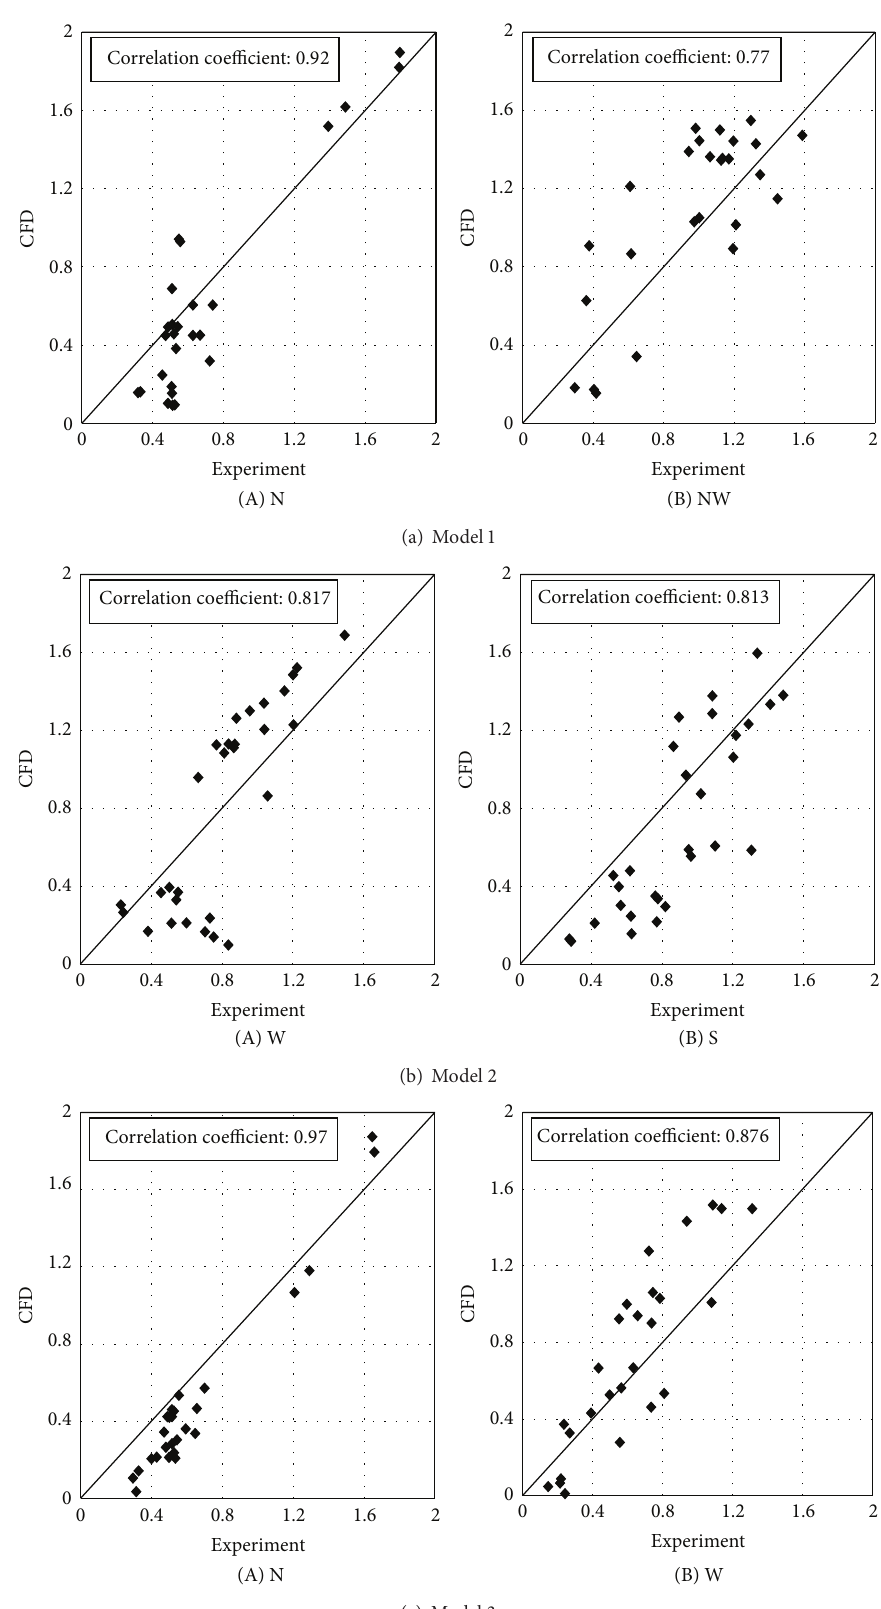
Figure 8: Correlation coefficients and standard errors of the wind speed experiment and CFD results in each